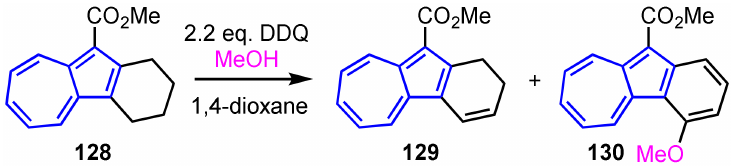
Scheme 32. Oxidation of the α -methylene of 128 with DDQ in the presence of